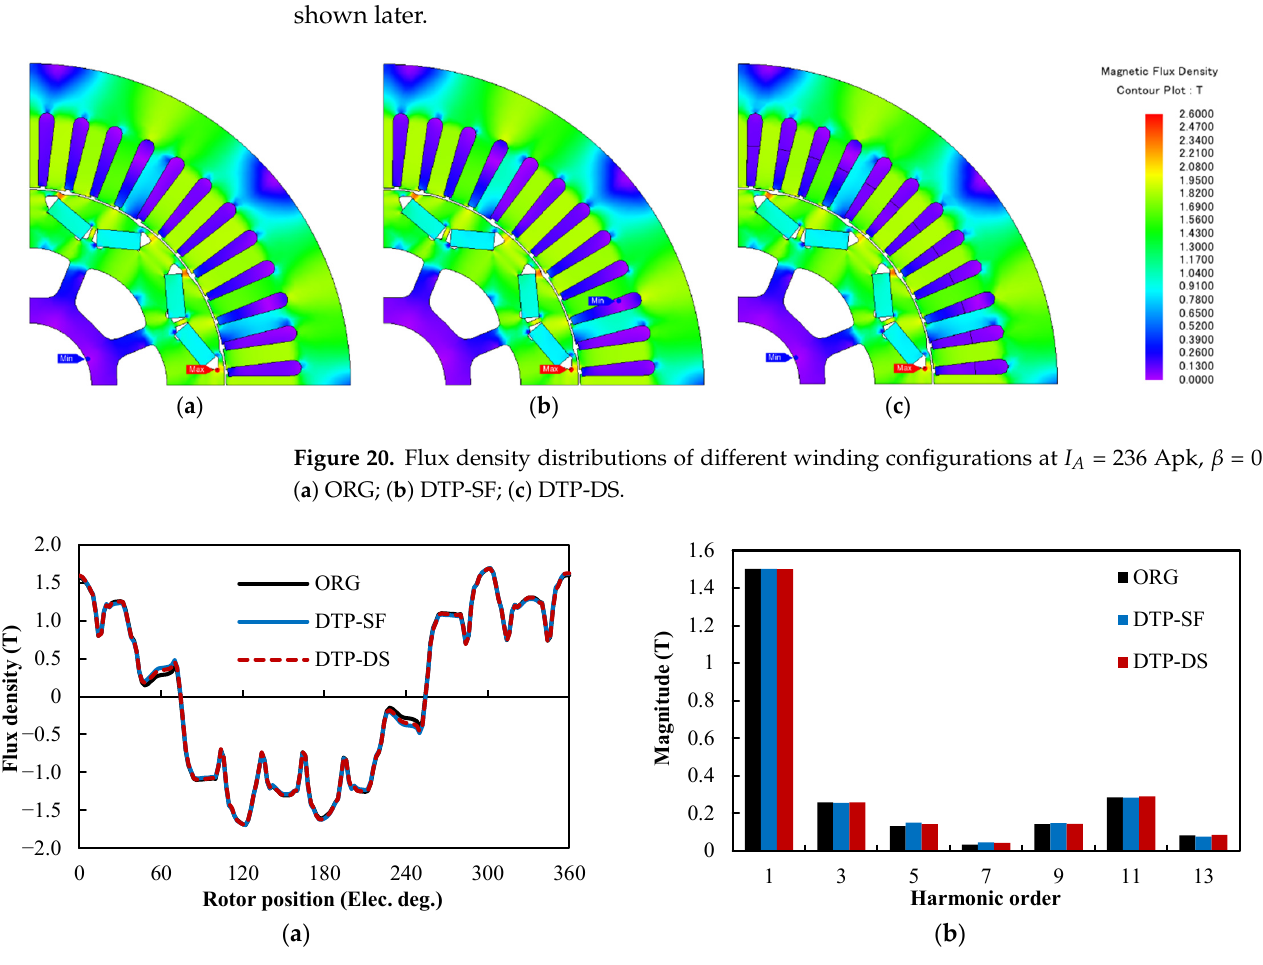
Rotor position (Elec. deg.)